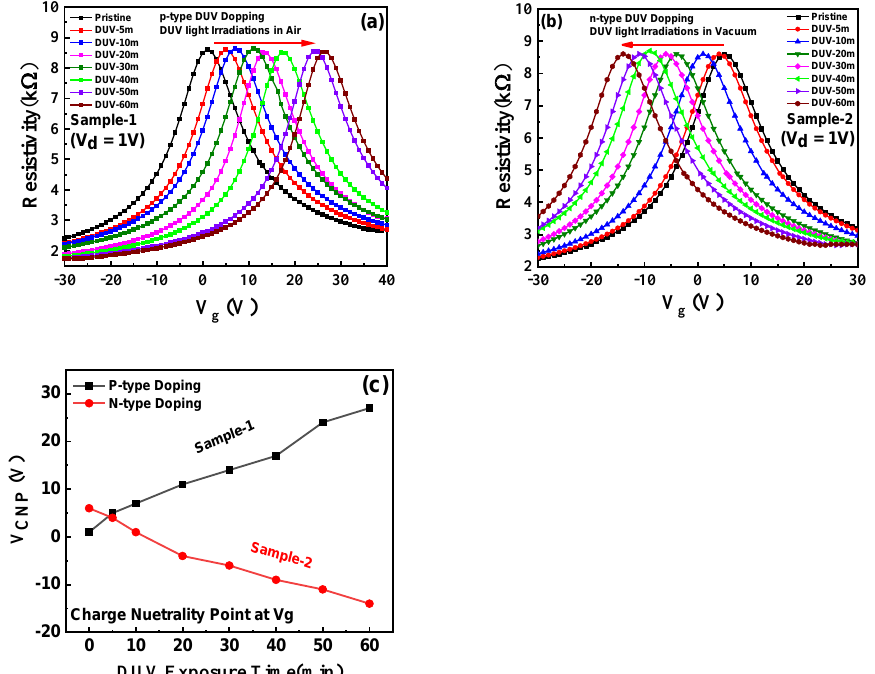
Figure 4. Electrical transport characteristics: ( a ) Resistivity as a function of back-gate voltage (V g ) for pristine and p-type doping by DUV irradiation in air with different exposure times for sample- 1. The p-type doping effect by DUV irradiation in air increased with an increase in exposure time. ( b ) Resistivity as a function of back-gate voltage (V g ) for pristine and n-type doping by